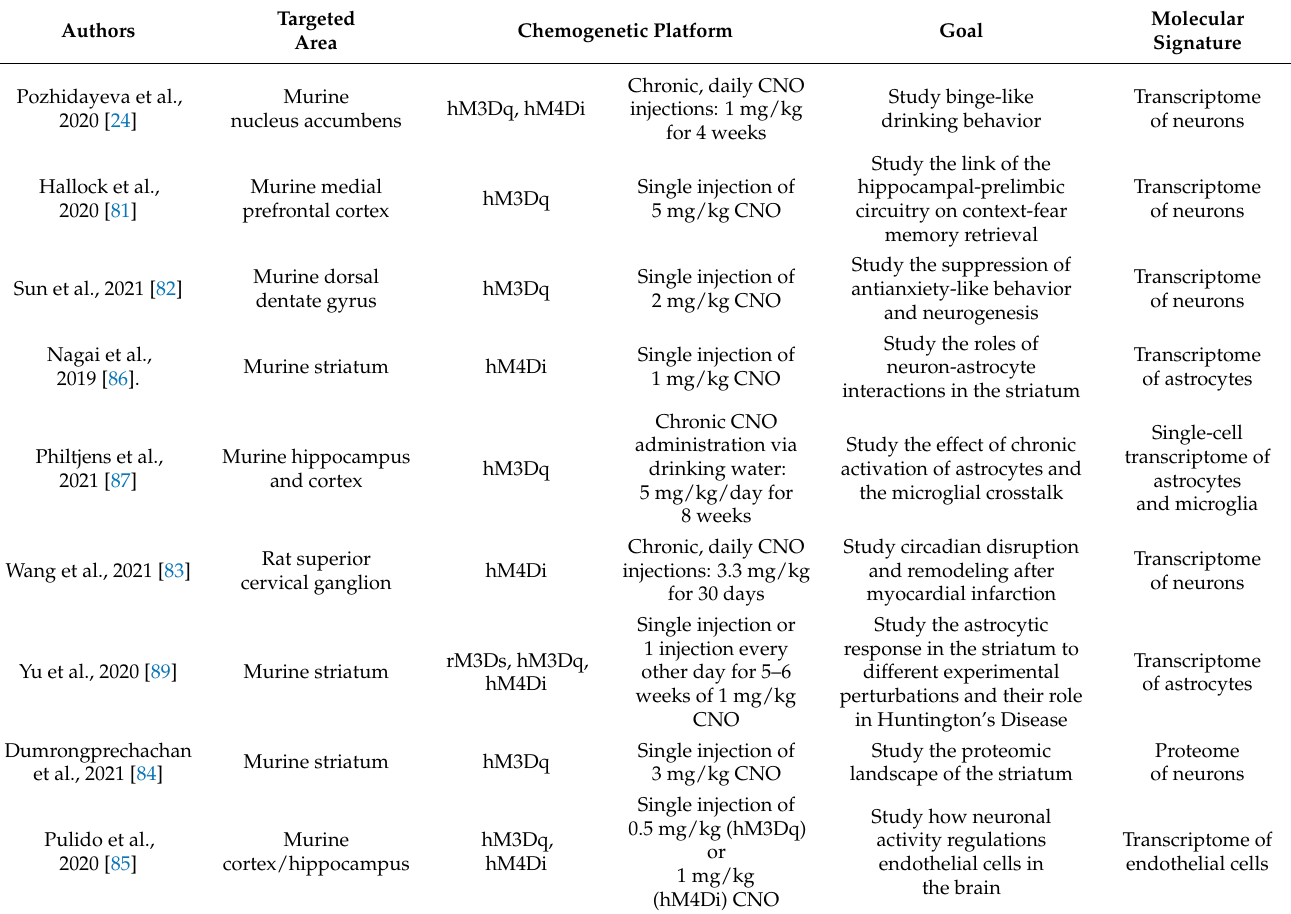
Table 2. Overview of DREADD studies digging into the molecular signature of chemogenetic